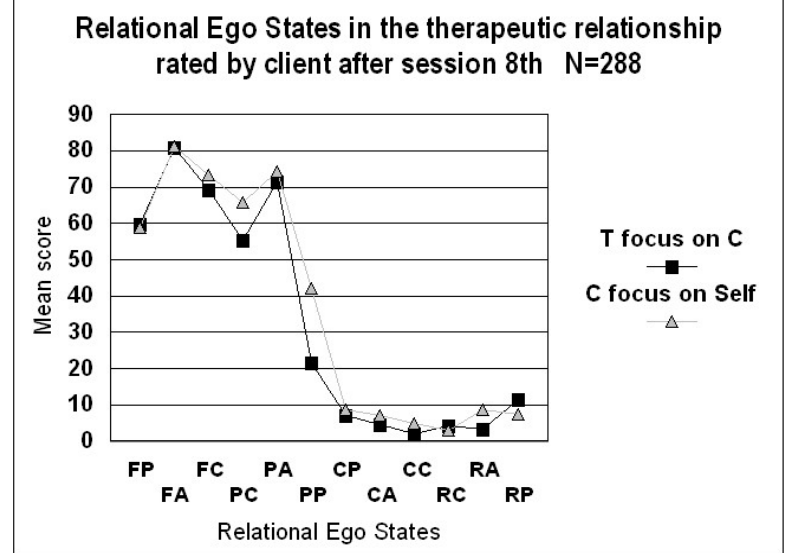
Figure 3: The two profiles of the means of the Relational ES of therapist and